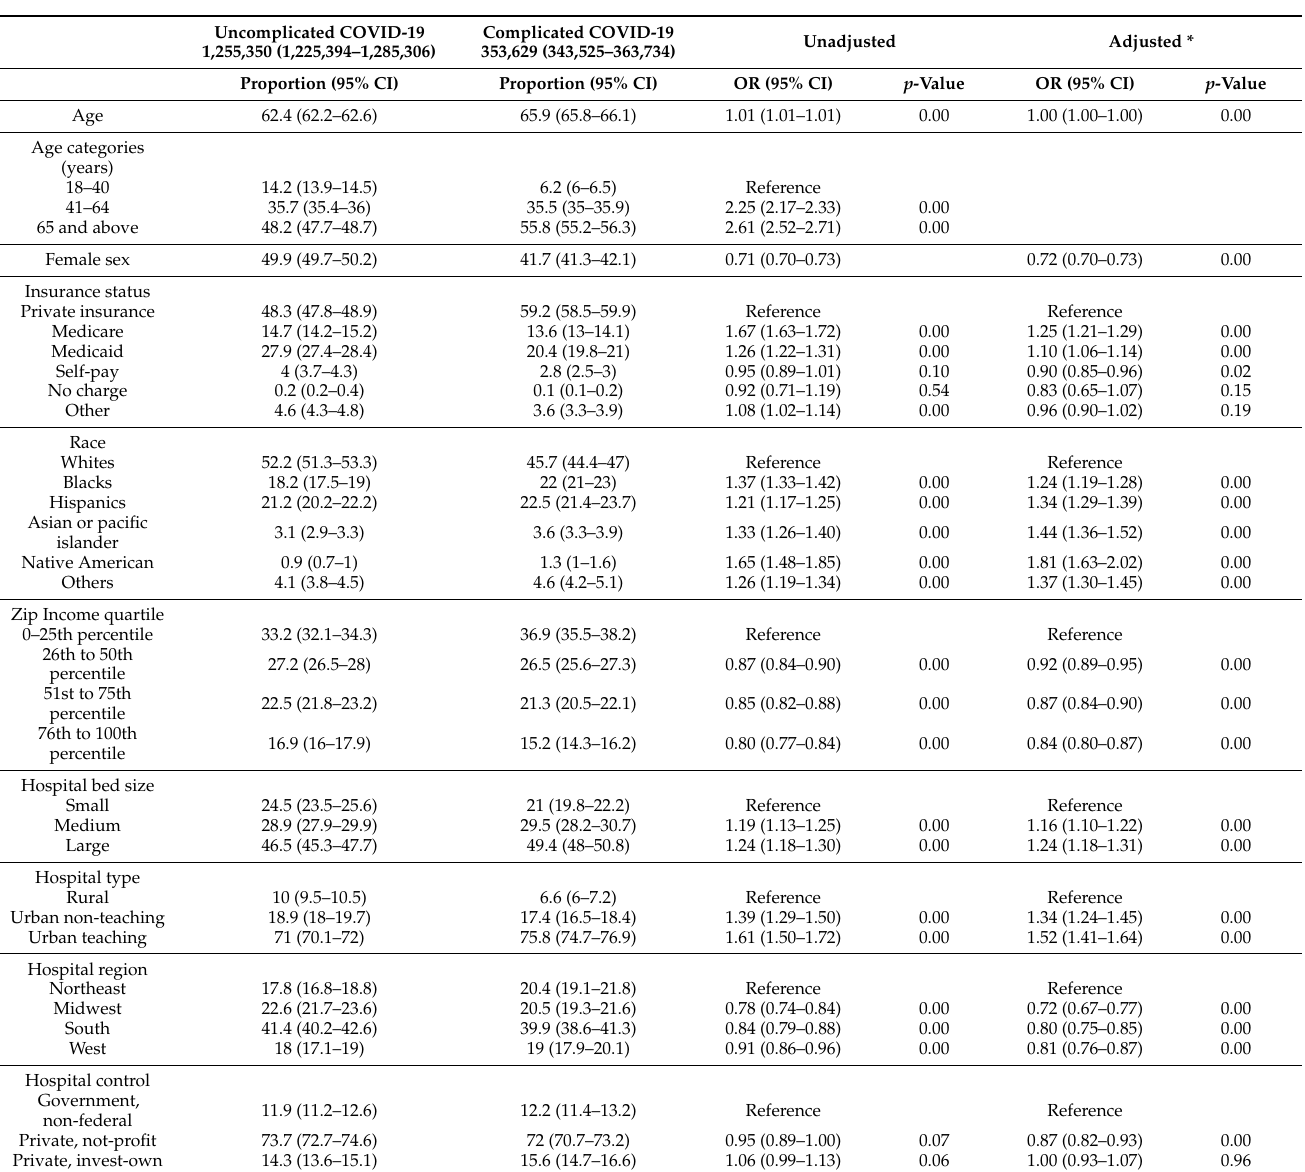
Table 4. Socioeconomic Predictors of Complicated COVID-19.